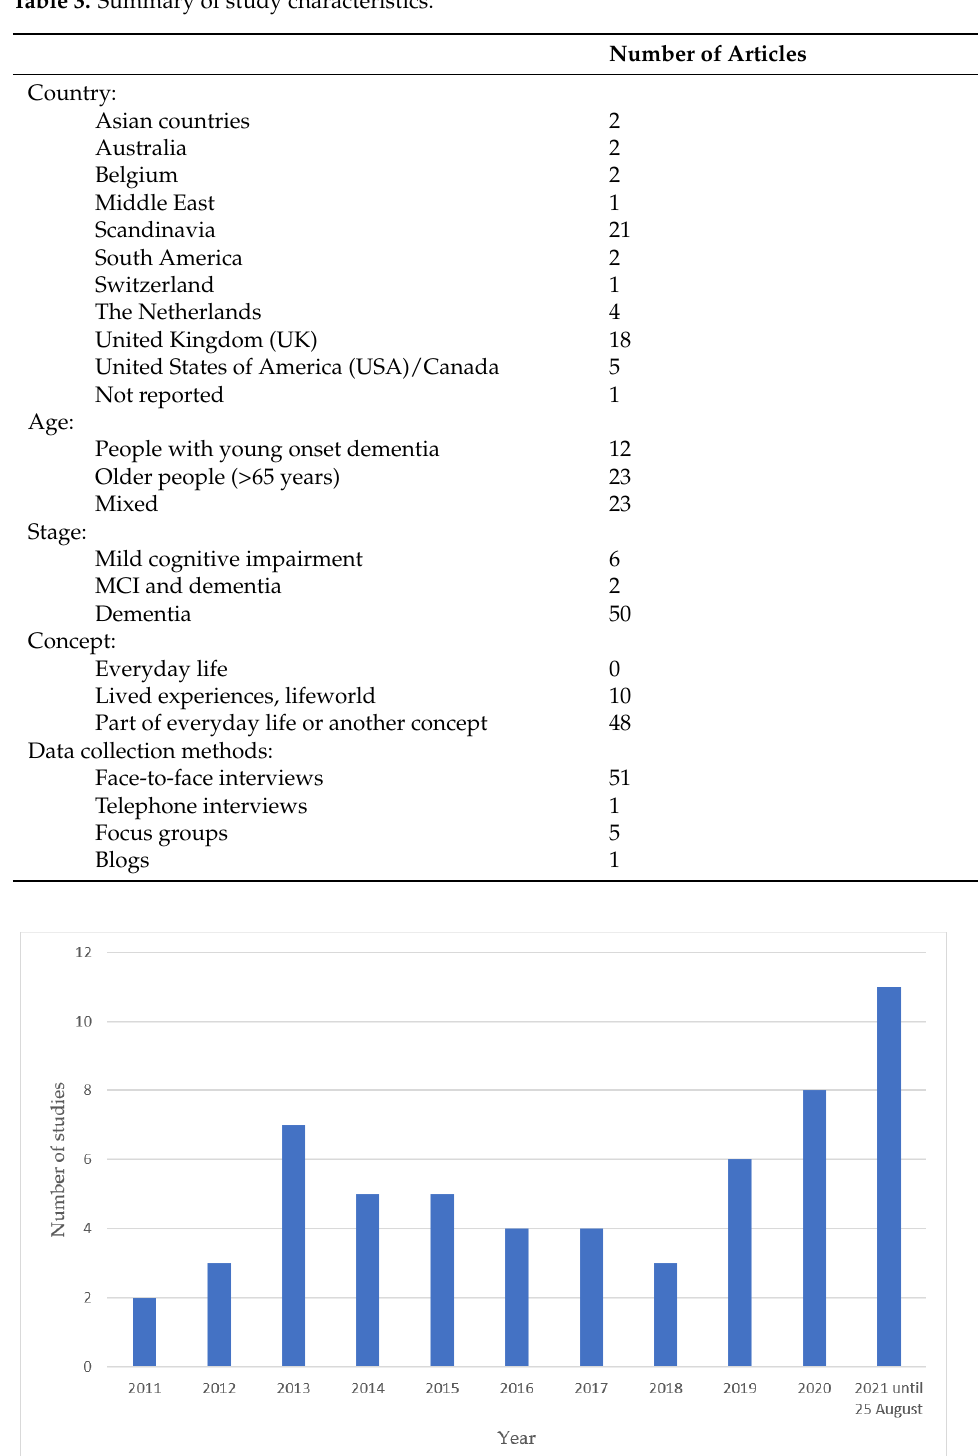
Table 4. Description of the seven spheres of everyday